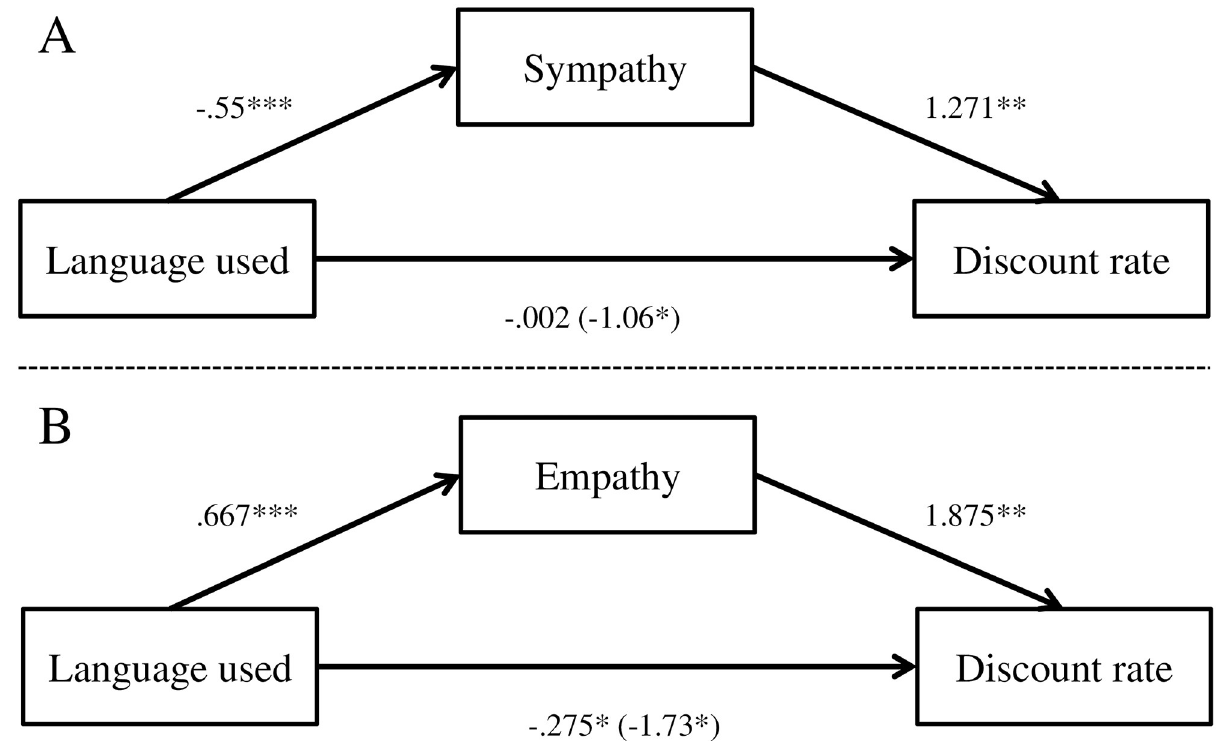
Fig 2. The effect of the language used on discount rate mediated by experienced emotions. All entries are raw (unstandardized) coefficients. The association between the mediator and the DV is represented by a coefficient from a model where the IV is also a predictor of the DV. Numbers in parentheses refer to the direct effect of the language used on discount rate. Panel A: Study 1. Panel B: Study 2. � < 0.05, �� < 0.01, ��� < 0.0001.